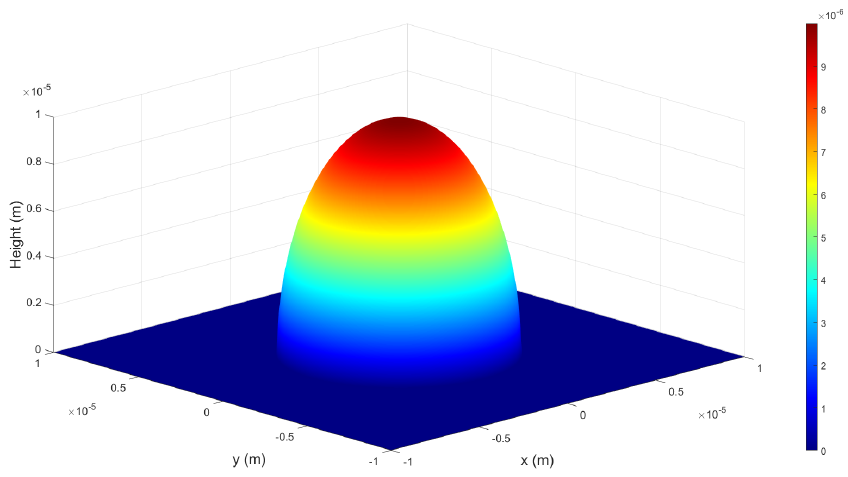
Figure 3. Ideal target for depth profile comparison in